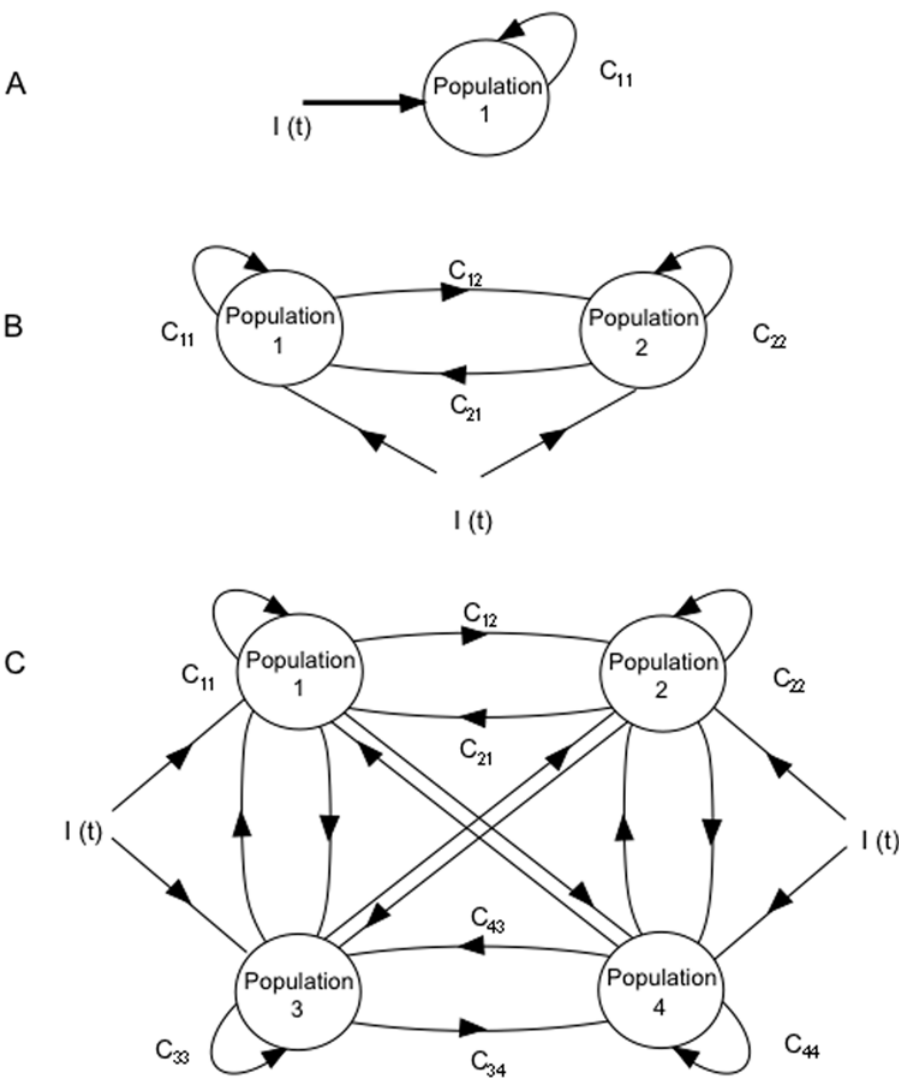
Figure1. Schematic diagrams of network architecture of the single population,twopopulation, andfour population models. A) Single- population firingrate model.In thesingle-populationmodel thenetwork receives input from anexternalcurrent I(t) during the cueperiodof a simulated working memory task. The synaptic activity S(t) , and consequently the firing rate increases from the input of the external current, resulting in a dynamic increase in its effective self connectivity C 11 as a result of a concomitant dynamic change in synaptic facilitation W 1 . B) 2-population distributed model. In the distributed 2-population model, 2 ‘‘local’’ networks, 1 and 2 are connected recurrently by long-range projections C 12 and C 21 whose strength is weaker than the populations’ self connectivity C 11 and C 22 . Both populations receive input from an external current I(t) during the cue period of simulated working memory task. This results in changes in their respective population firing frequencies along with changes in their effective long-range projections and self couplings through dynamic facilitation. In the spiking unit version of the model, populations 1 and 2 consist of networks of 100 (or 1000) spiking units each with all-to-all connectivity. C) 4-population model.In the4-population model,four local networks (1, 2, 3, and 4) all receive input from an external current I(t) during the cue period of the simulated working memory task. Each local population receives input from self connectivity, and weaker input from the long-range projections from the other populations. Long-range projections between the population pair 1 and 2, and between the pair 3 and 4 (i.e. C 12 , C 21 , C 34 , and C 43 ) are stronger than the connection strength between populations 1 and 3 or 4, or between 2 and3 or 4. In the spiking unit version of the model with 200 units, each population corresponds to a network of 50 spiking units with all to all connectivity. In the spiking unit version of the model with 2000 units, each population corresponds to a network of 500 units with all to all connectivity. The strength of the connections is scaled such that the total strength of connectivity to units is the same as the 200 unit network.